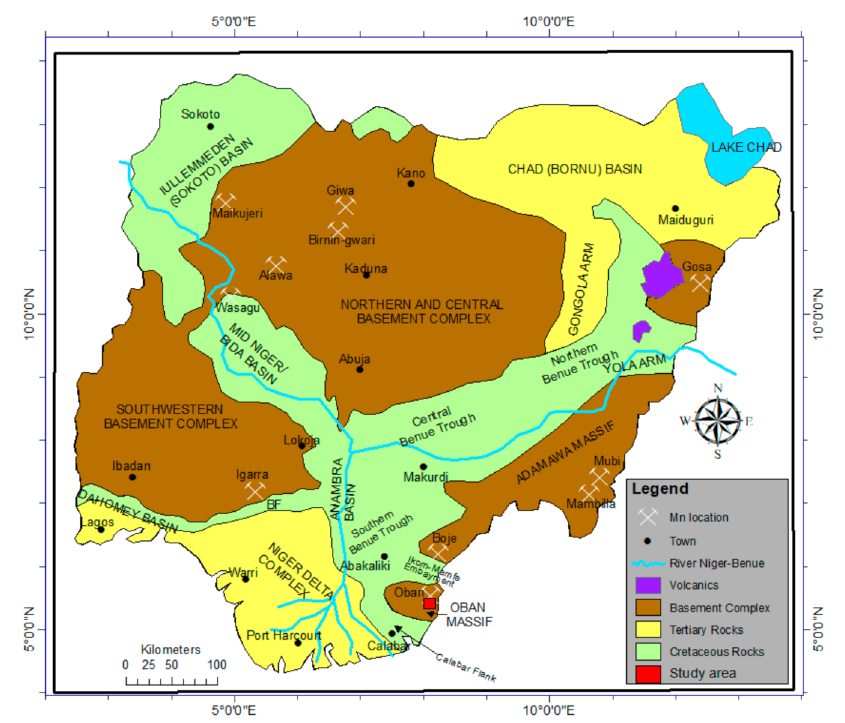
Figure 1. Simplified geological map of Nigeria showing the locations of known manganese occur- rences (Source: